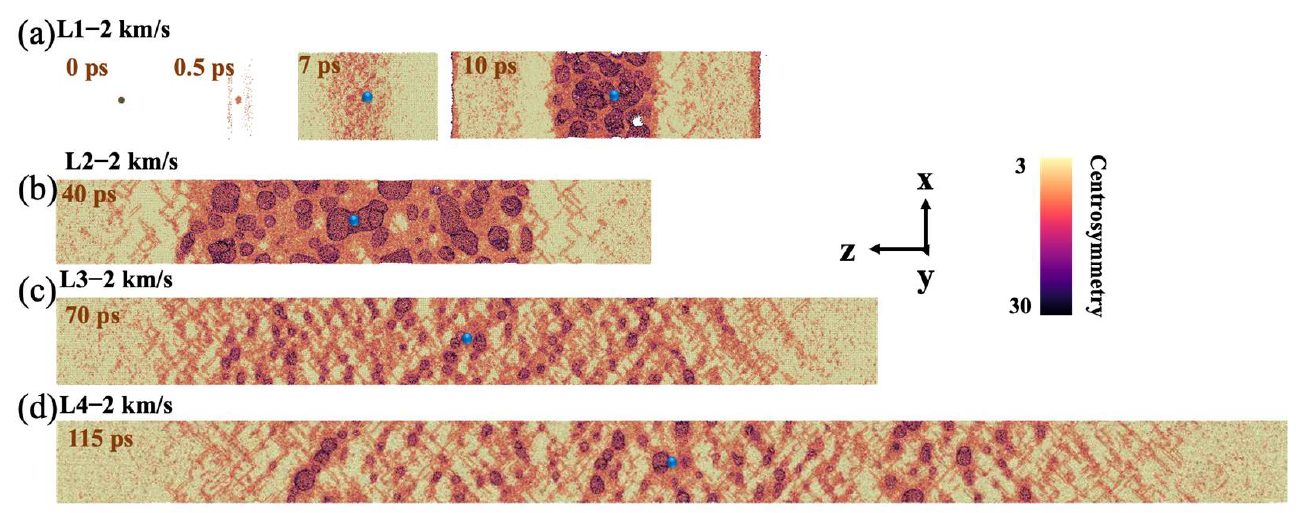
Figure 9. Microscopic views of void evolution and damage for ( a ) L1, ( b ) L2, ( c ) L3, and ( d ) L4 at v 0 = 2 km/s. The microscopic views were sliced from the center axis, and atoms with centrosymmetry values less than 8 were deleted.